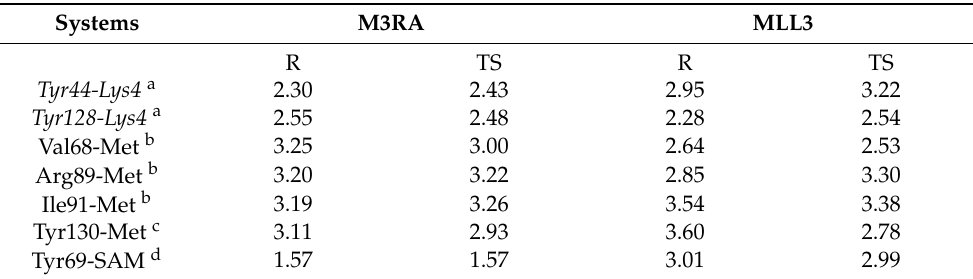
Table 4. Mean values for some selected interaction distances between the cofactor and the substrate with the catalytic site, for both M3RA and MLL3 at their respective RS and TS. Distances are in Å. Systems